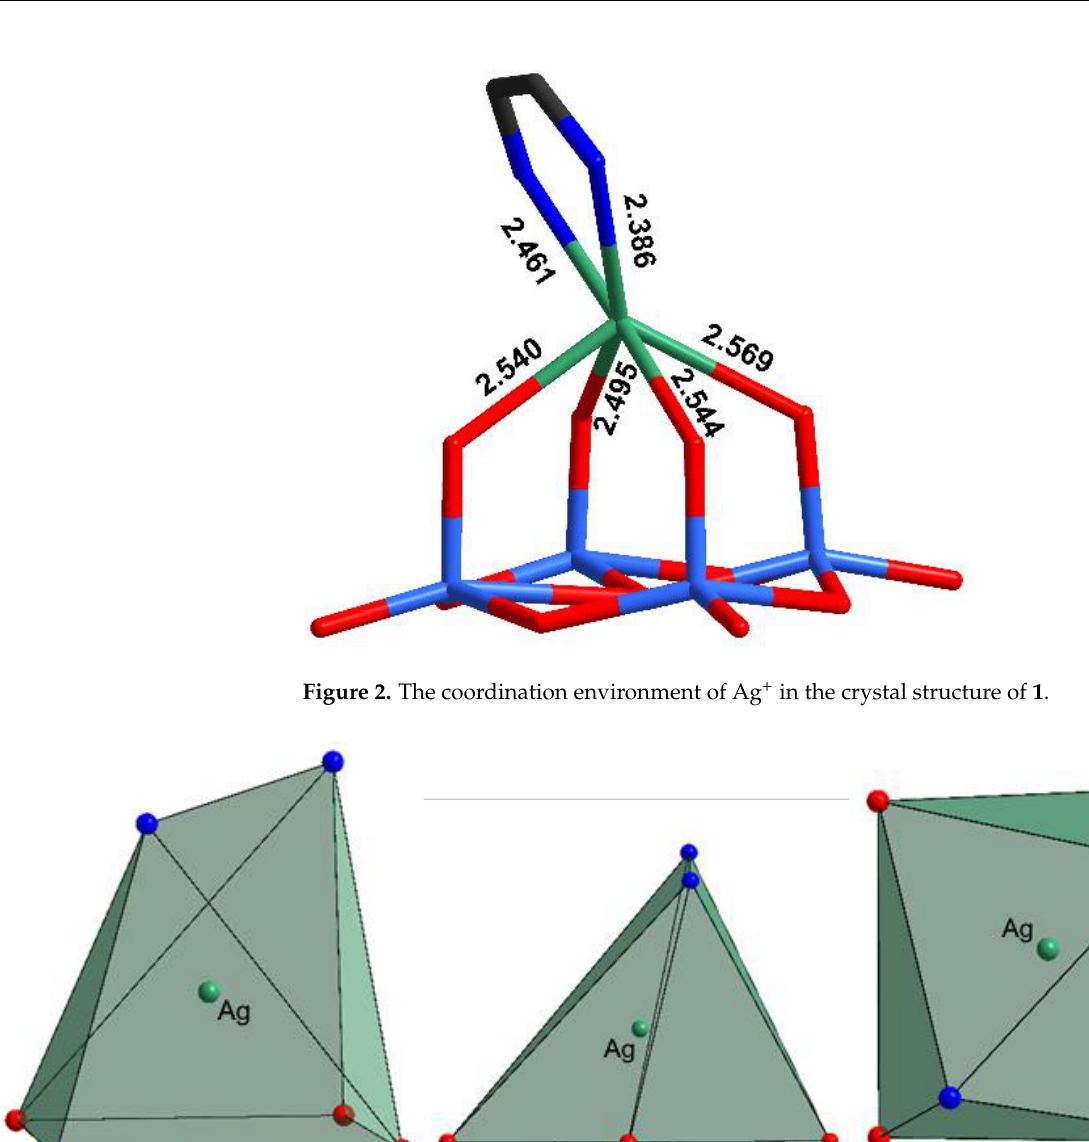
Figure 3. The coordination polyhedron of Ag + . O-atoms are red, N-atoms are blue.